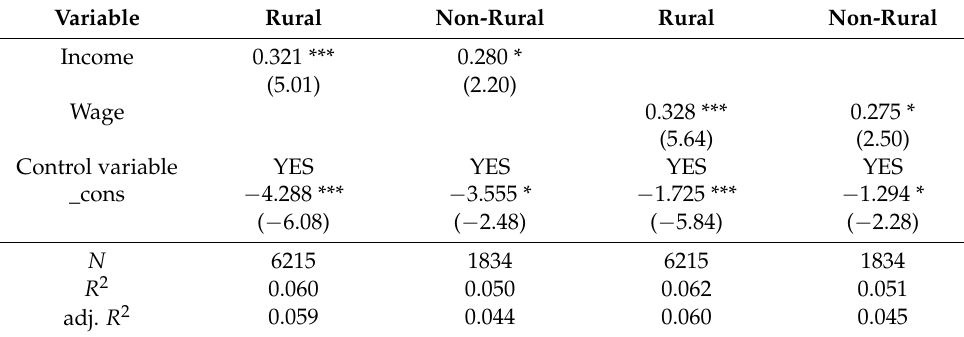
Table 7. Heterogeneous effects of different exercise frequencies on income.